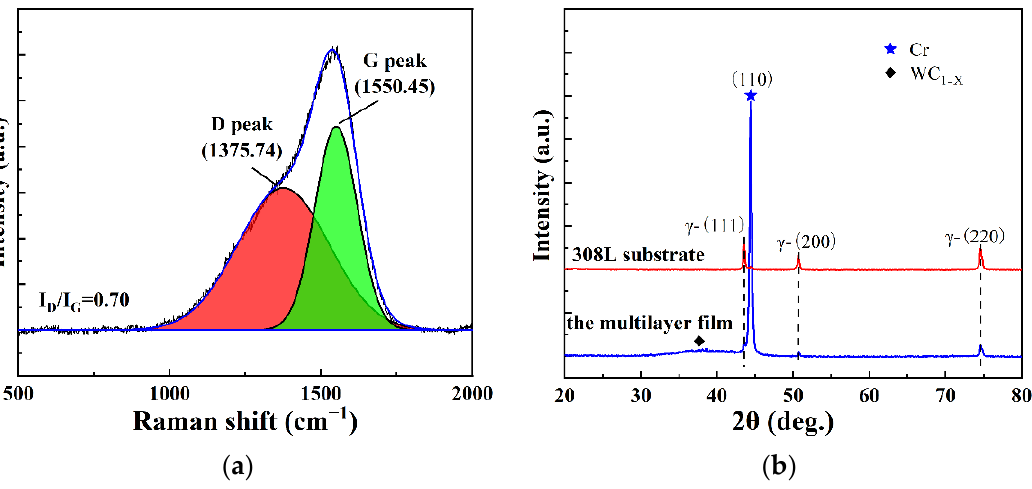
Figure 3. Raman spectra ( a ) and XRD pattern ( b ) of the Cr/W-DLC/DLC multilayer films.